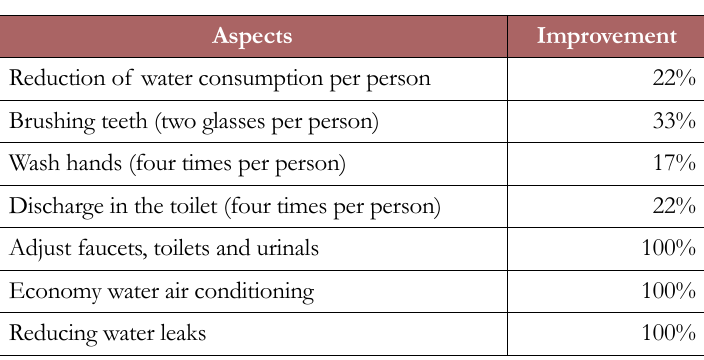
Table 6. Level of improvement in aspects to reduce water